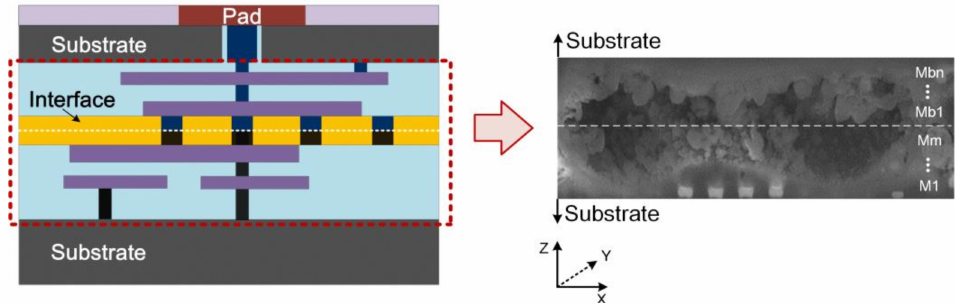
Figure 9. FIB-sectioned image of the burn-out